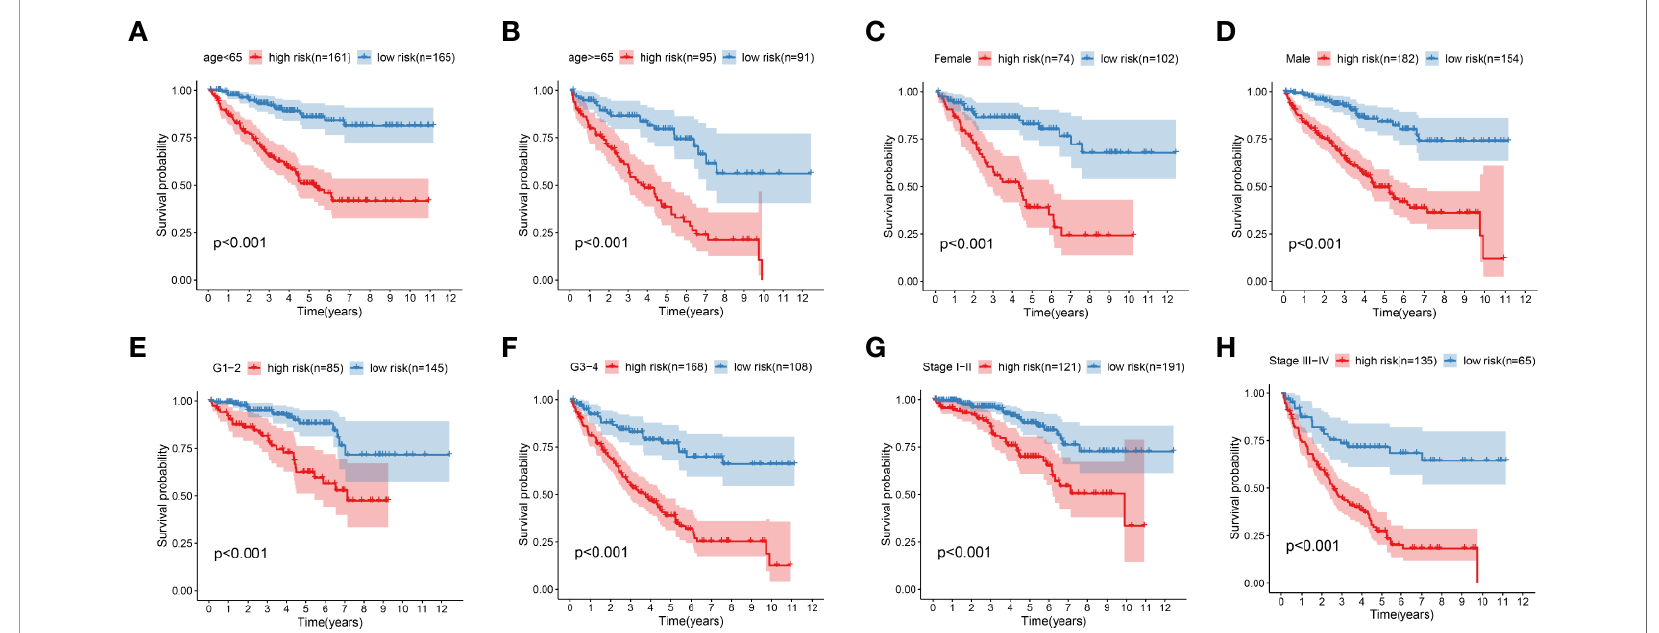
FIGURE 5 | Kaplan-Meier curve analysis for the high-risk group and low-risk group strati fi ed by clinical factors, including age (A, B) , gender (C, D) , grade (E, F) , stage (G, H)